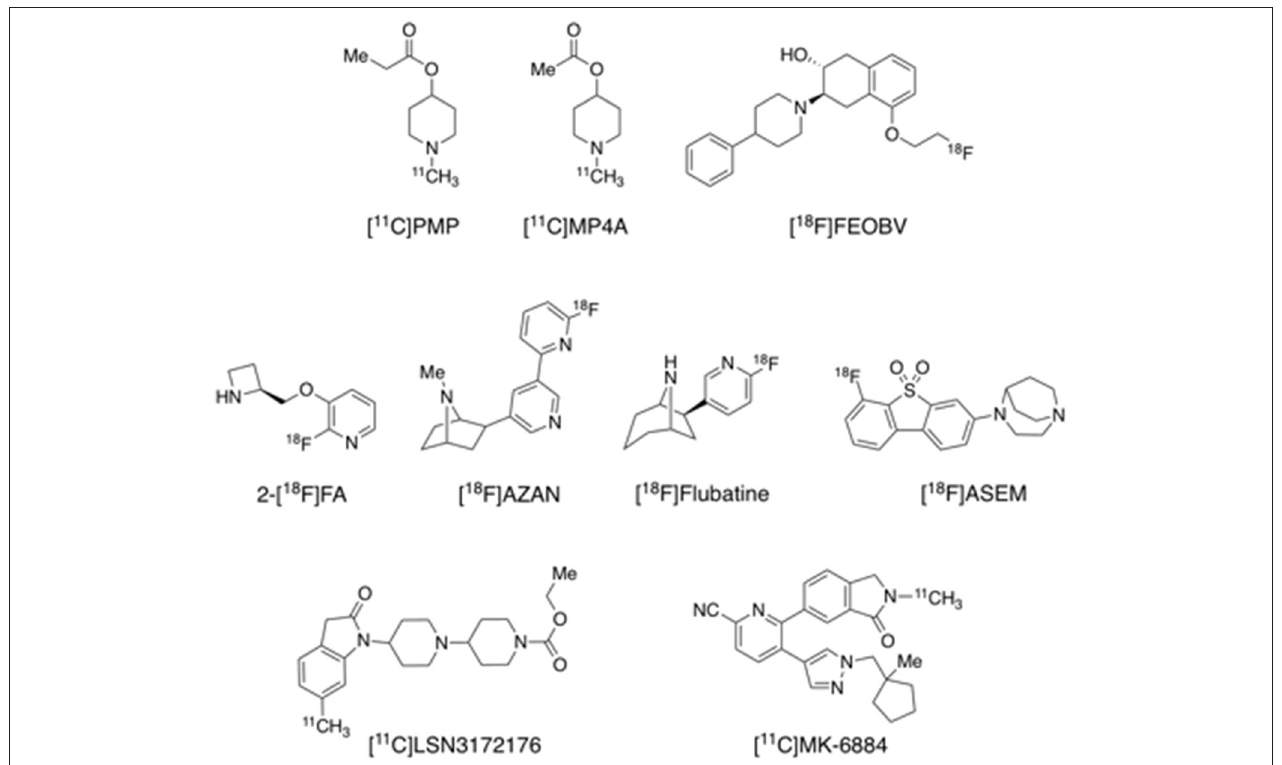
FIGURE 6 | Structures of representative PET radiotracers for cholinergic